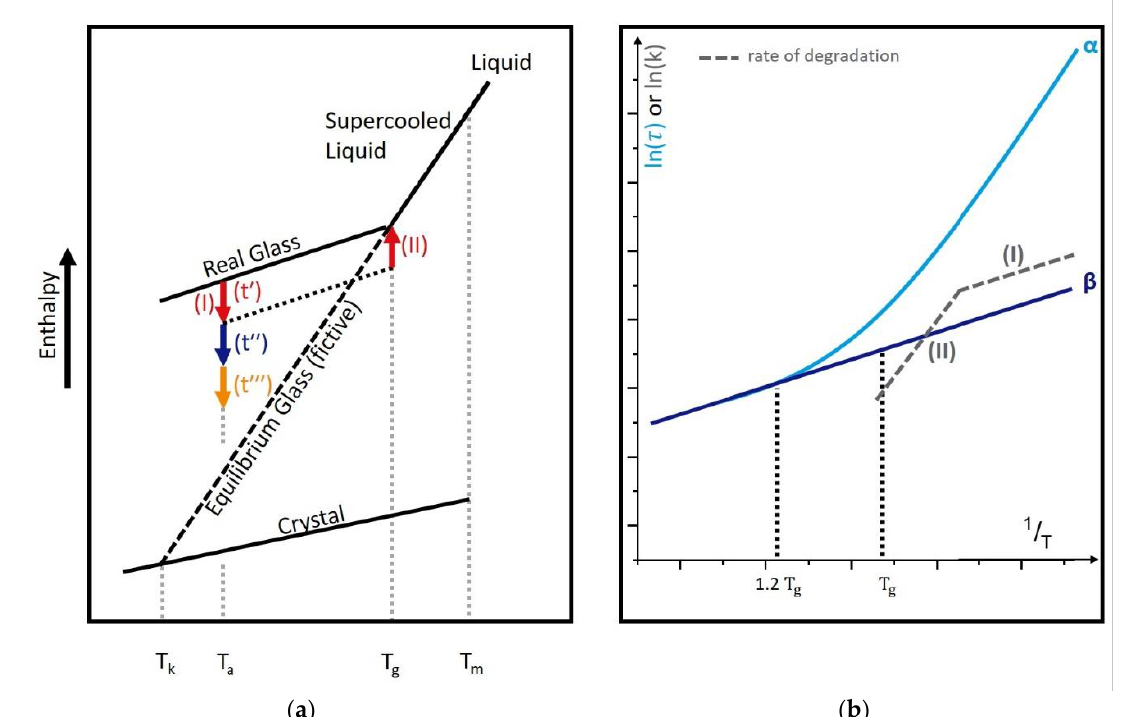
Figure 1. Theoretical considerations concerning relaxation. ( a ) Enthalpy relaxation diagram of solids with the melting temperature T m , the glass transision temperature T g , the annealing or tempering temperature T a , and the Kauzman temperature T K . (t (cid:48) )–(t (cid:48)(cid:48)(cid:48) ) symbols indicate the tempering process of a glass at a certain temperature T a . In the context of this review, the “real glass” represents our freshly prepared lyophilized formulation. The diagram is modified and adapted to the focus of this review [16,17,23,43,44,46,48]. ( b ) Model of the dominant relaxation modi. The influence of α - and β -relaxations on a degradation process with the constant k in dependence on temperature and T g . (I) degradation is governed by β -mobility; (II) degradation is governed by α -mobility